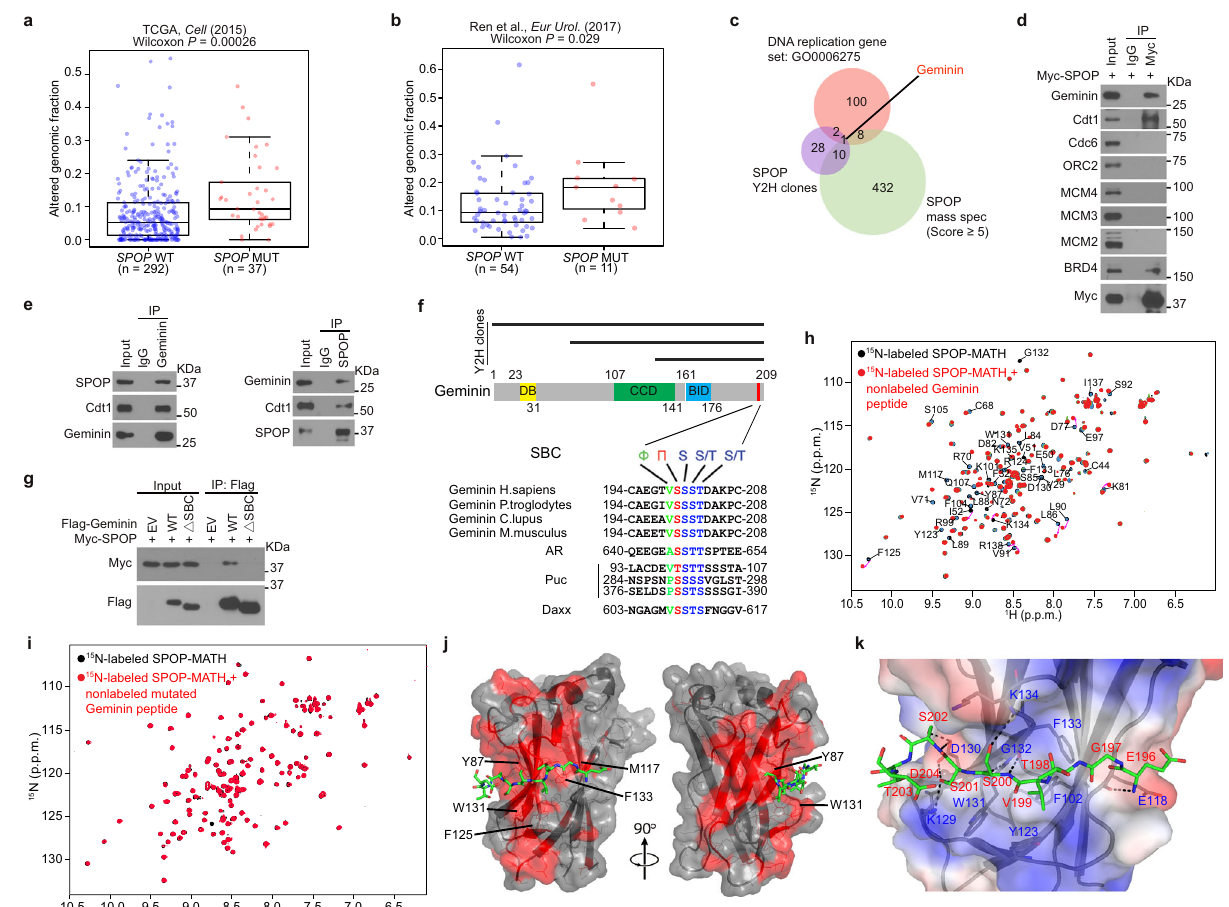
Fig. 1 Identi fi cation of the DNA replication factor Geminin as a SPOP-binding protein. a , b Analysis of altered genomic fraction in prostate cancer patient specimens with wild-type (WT) (blue dots) or mutant (MUT) (red dots) SPOP in The Cancer Genome Atlas (TCGA) dataset 28 ( a ) and an independent prostate cancer whole-genome sequencing dataset 44 ( b ). Data were generated using the cBioPortal (https://www.cbioportal.org/) online tool. Boxplots show median, interquartile ranges, and all data points. P values were calculated using one-sided Wilcoxon rank-sum test. c Venn diagram showing the overlap of yeast two-hybrid screen data from Fudan University (Shanghai), mass spectrometry-based SPOP interactome from Mayo Clinic, and the DNA replication gene set. d Co-IP analysis of DNA replication-related proteins in 293T cells transfected with Myc-SPOP. e Co-IP analysis of endogenous proteins in PC-3 cells using the indicated antibodies. f A Geminin domain structure diagram showing a putative evolutionally conserved SBC motif (in red) located at the C-terminal end of Geminin (middle and bottom). All three Y2H clone clusters contain this motif (top). g Co-IP analysis of indicated proteins in 293T cells transiently transfected with Myc-SPOP-WT or Δ BTB mutant. h , i Perturbations in the 1 H- 15 N HSQC NMR spectra of 15 N-labeled SPOP MATH upon titration with unlabeled WT ( h ) or mutated ( i ) Geminin peptide (amino acids 195 – 209). j Crystal structure of SPOP-MATH (surface representation) in complex with the Geminin peptide (amino acids 195 – 209) in stick representation. Peptide residues 196 – 204 were modeled in the electron density. The red surface corresponds to SPOP residues for which chemical shift perturbations were detected in the 1 H- 15 N HSQC NMR spectrum of 15 N-labeled SPOP MATH titrated with unlabeled Geminin peptide. Selected SPOP residues frequently mutated in cancer patients are labeled. k Representation of Geminin peptide and SPOP residues at the binding interface. Putative intermolecular hydrogen bonds are shown in black dashes. The potential electrostatic surface of SPOP is shown in blue and red for positive and negative charges, respectively. Source data are provided in this paper or Mendeley database (10.17632/ 8n7xt5rkhc.1). Similar results for ( d ), ( e ), ( g ) panels were obtained in two independent